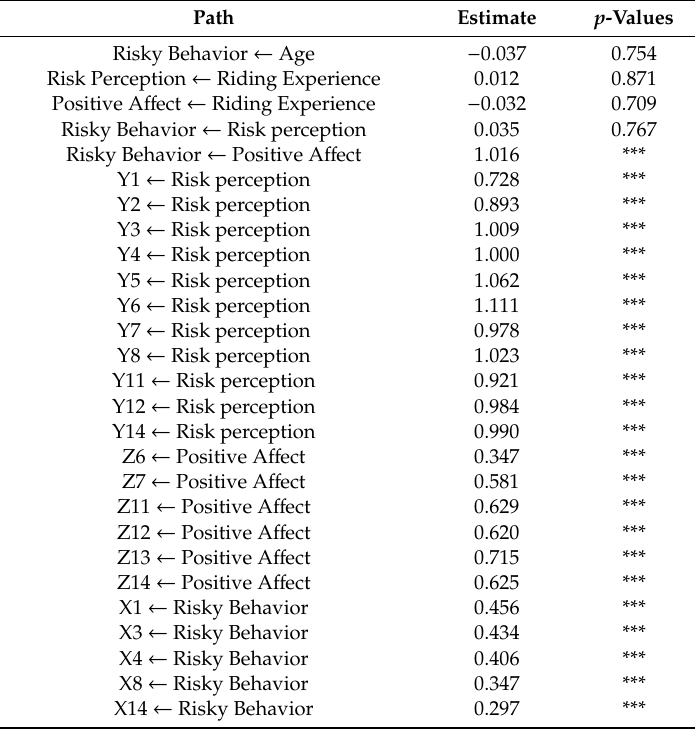
Table 6. Standardized coe ffi cient weight of the developed